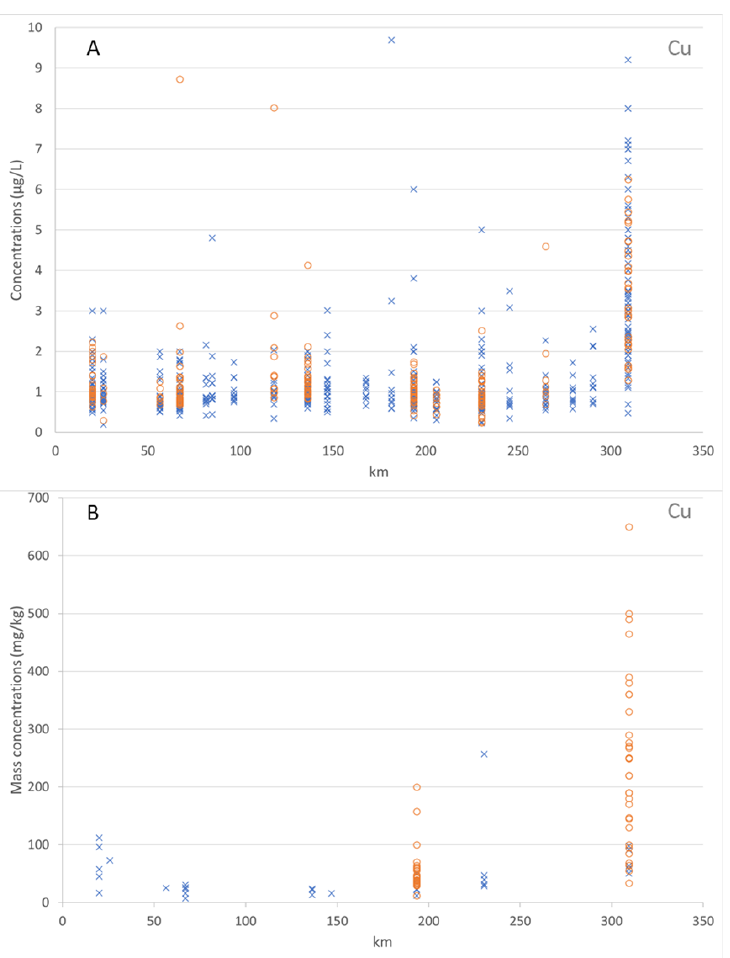
Figure 6. ( A ) Dissolved copper concentrations (blue crosses, µg/L, years 2012 to 2019) and total copper concentrations (orange circles, µg/L, years 2017 to 2019) in the water column along the Mosel river (from the source to the French border, in km), and ( B ) adsorbed copper mass concentrations on the bed sediment (blue crosses, mg/kg, particles < 2 mm) and adsorbed copper mass concentrations on the suspended sediment in the water column (orange circles, mg/kg, particles < 2 mm) along the Mosel river (from the source to the French border, in km), from the year 2012 to 2017.